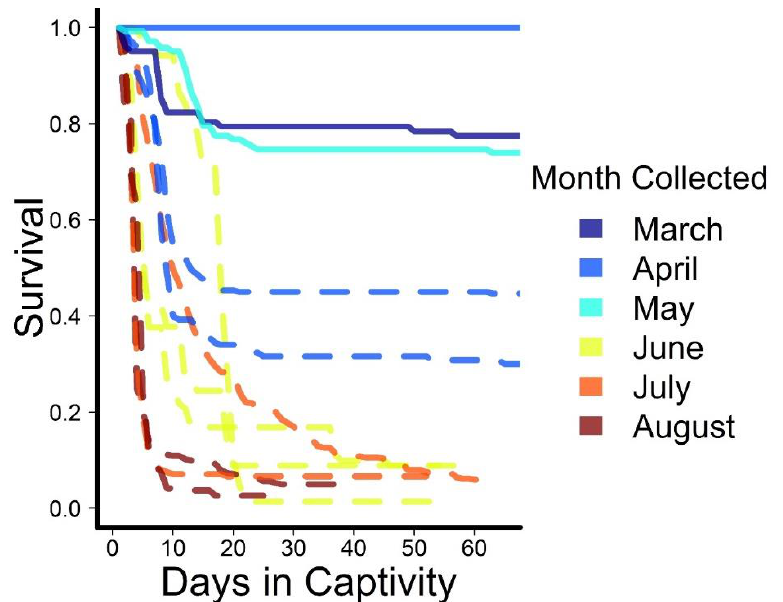
Figure 4. Daily cumulative survival of Rio Grande silvery minnow captured during surface flows (solid lines) or during streamflow intermittency (dashed lines) and held in captivity in 2018 and 2020.